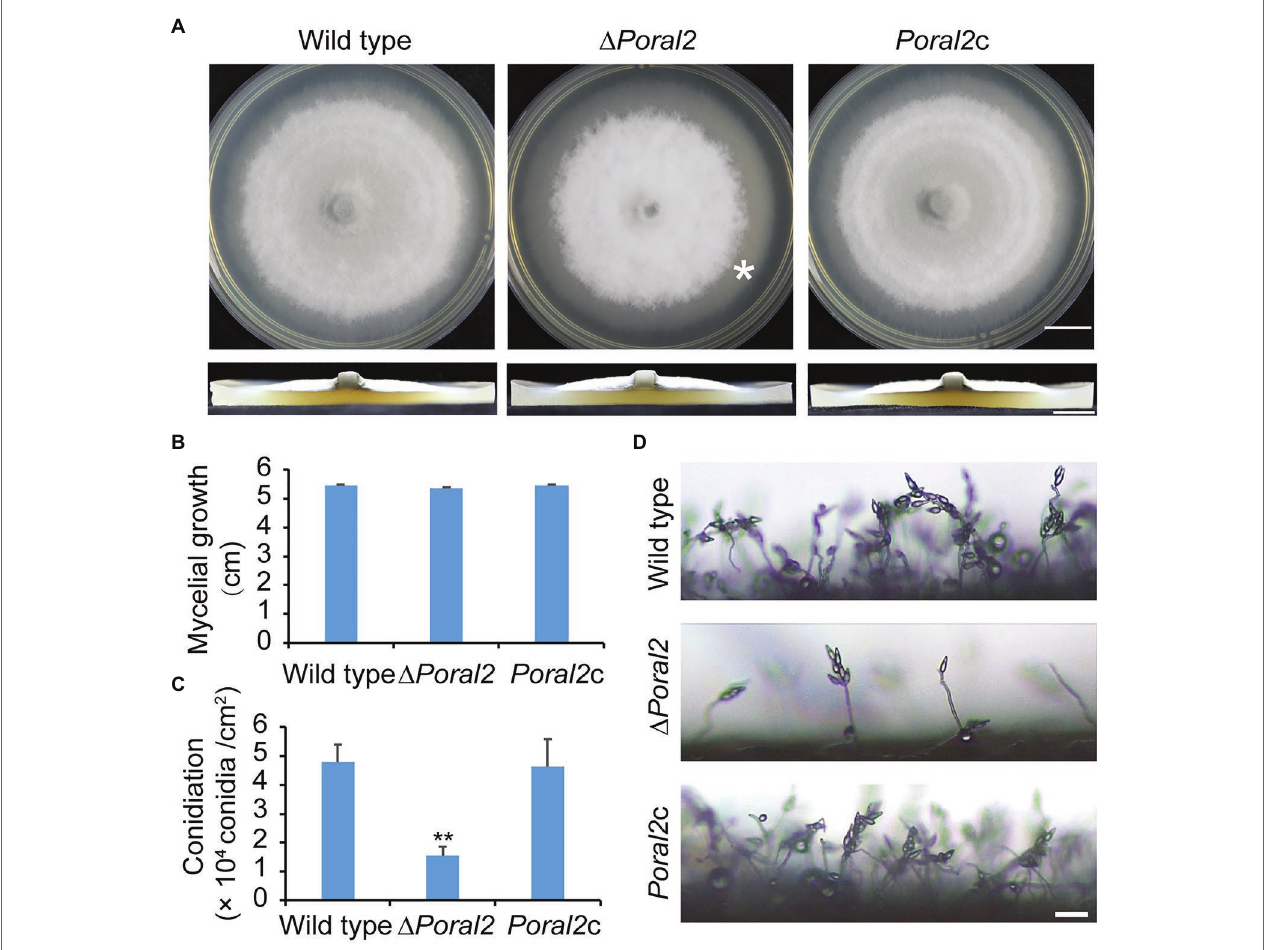
FIGURE 2 | Mycelial growth and sporulation in ∆ Poral2 . (A) Colonies of wild type, ∆ Poral2 , and PoRAL2 -complemented ∆ Poral2 ( Poral2c ) P. oryzae strains. Asterisks refer to delays in differentiation of aerial hyphae. The strains were cultured on complete medium (CM) at 25 ° C for 10 days. Bar = 1 cm. (B) Mycelial diameters (cm) of wild-type, ∆ Poral2 , and Poral2c colonies. (C) Conidiation of wild-type, ∆ Poral2 , and Poral2c strains. (D) Conidiophore development of P. oryzae strains. Bar = 20 μ m. (B,C) Error bars represent standard deviations. Significant differences compared with the wild type were estimated by Tukey’s HSD test: ** p <